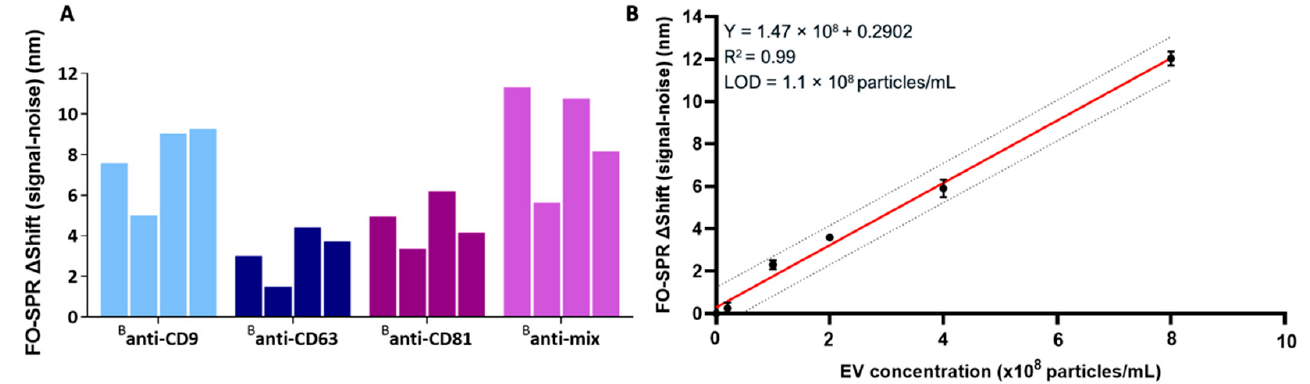
Figure 4. ( A ) FO-SPR sandwich bioassay with different antibody combinations for detecting MCF7 EVs in 100-fold diluted pooled plasma. Bar graphs represent the FO-SPR shifts (after subtracting the negative control, i.e., SPR signal for 0 particles/mL) obtained from four independent measurements by combining anti-EpCAM capture antibody with different detection antibodies ( B anti-CD9, B anti-CD63, B anti-CD81 or B anti-mix) for detecting MCF7 EVs at 1 × 10 9 particles/mL concentration. ( B ) FO-SPR-based detection of a series of MCF7 EV concentrations when using anti-EpCAM/ B anti-mix antibody combination in 100-fold diluted pooled plasma (obtained after subtracting the negative control, i.e., SPR signal for 0 particles/mL). Simple linear regression fitting was performed by GraphPad Prism software. The dotted lines indicate the 95% prediction bands for a new observation. Error bars represent one standard deviation ( n = 3).